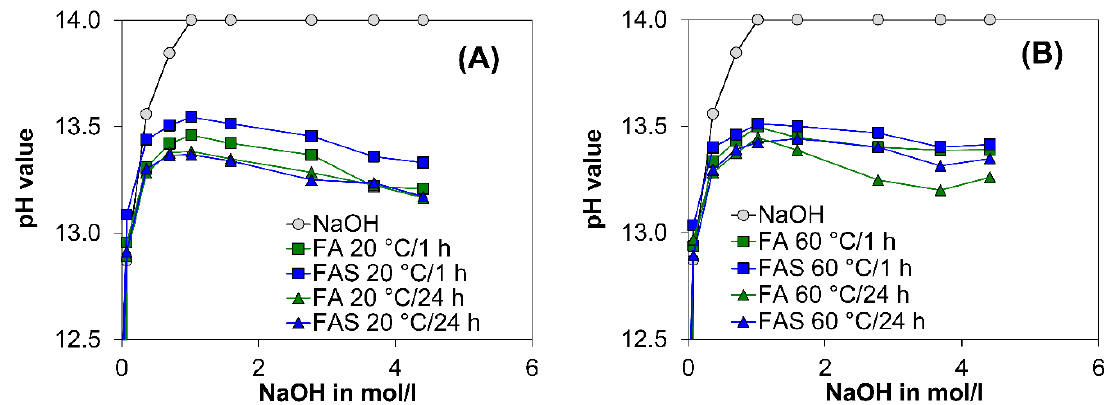
Figure 6. Eluate results of pure NaOH without raw materials (marked as circles), with fly ash (FA) and with 90% fly ash and 10% slag (FAS), after 1 h (marked with square) and after 24 h (marked with triangle), at 20 °C ( A ) and at 60 °C ( B ).